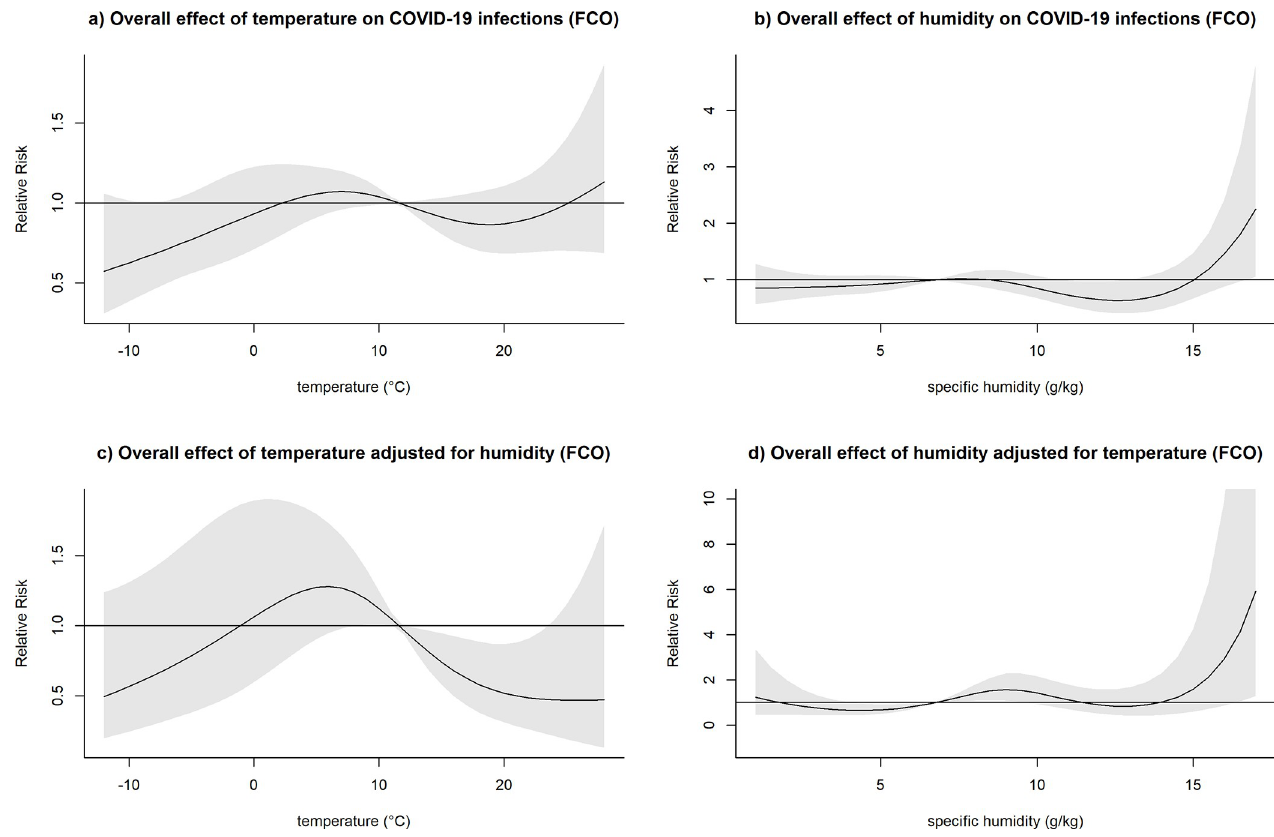
Fig 6. Overall effect of temperature and humidity on COVID-19 infections in Franklin County, Ohio (FCO). The relative risk of COVID-19 infection was plotted across the range of temperature/humidity to show the a) Unadjusted effect of temperature; b) Unadjusted effect of humidity; c) Effect of temperature adjusted for humidity; d) Effect of humidity adjusted for